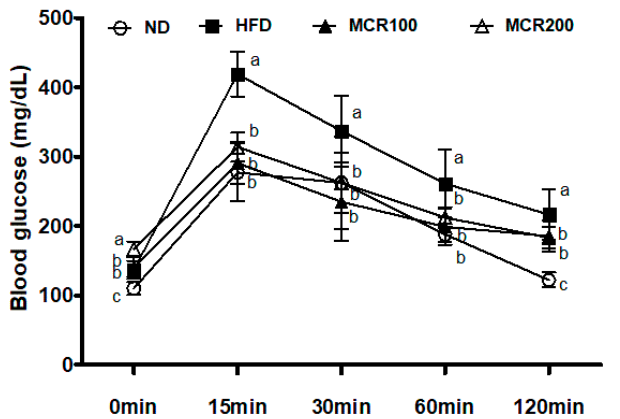
Figure 2. Effect of Mori Cortex radicis extract (MCR) on oral glucose tolerance (OGTT) in HFD-induced mice. Mice were fed ND or HFD with or without MCR (100 or 200 mg/kg b.w.) for 14 weeks. After 14 weeks of diet, mice were then fasted for 12h, and blood glucose levels were measured during 120 min. Results are presented as means ± SDs ( n = 8). Statistical significance was accepted for p values < 0.05. Small letters indicate significantly different from other groups.